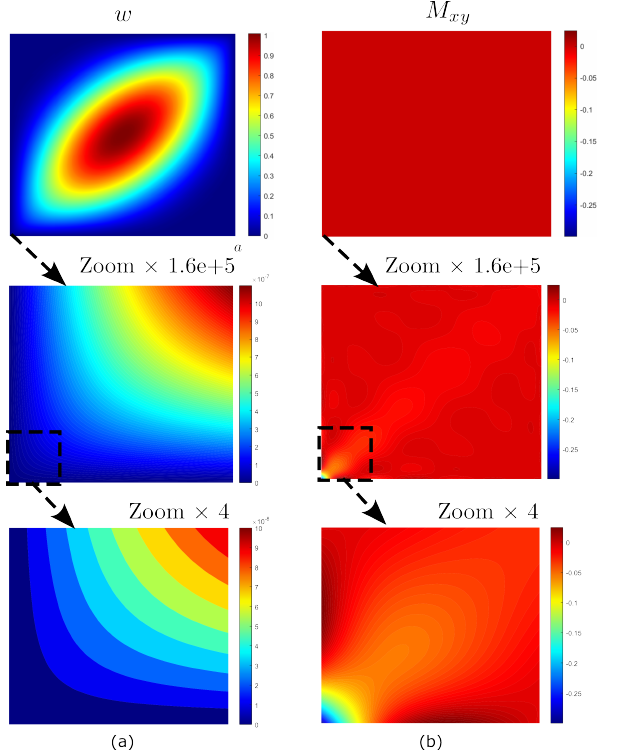
Figure 16. Highly anisotropic plate: mode shapes for free vibration analysis: ( a ) deflection shape and ( b ) twisting moment.